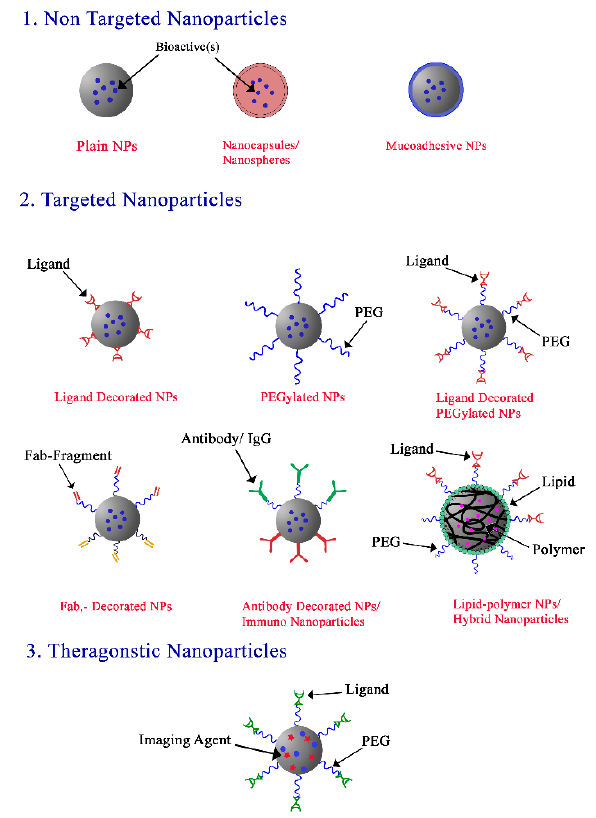
Figure 2. Different types of nanoparticles that are used for mucosal vaccine delivery.